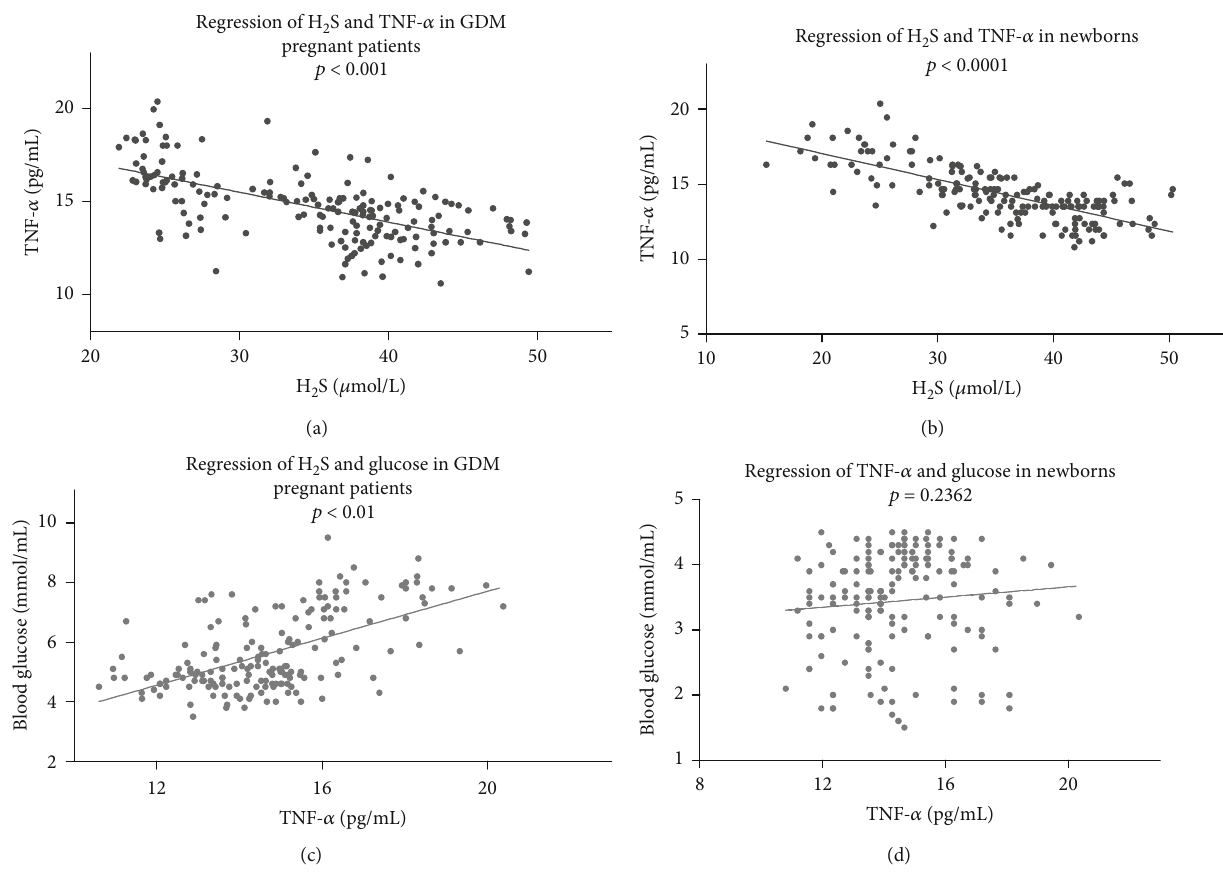
Figure 6: H S concentration in fl uenced the level of TNF- α in GDM patients. (a, b) H 2 levels in pregnant women and newborns. (c) The levels of TNF- α and glucose showed a positive correlation in pregnant women. (d) The levels of TNF- α and glucose showed no signi fi cant correlation in